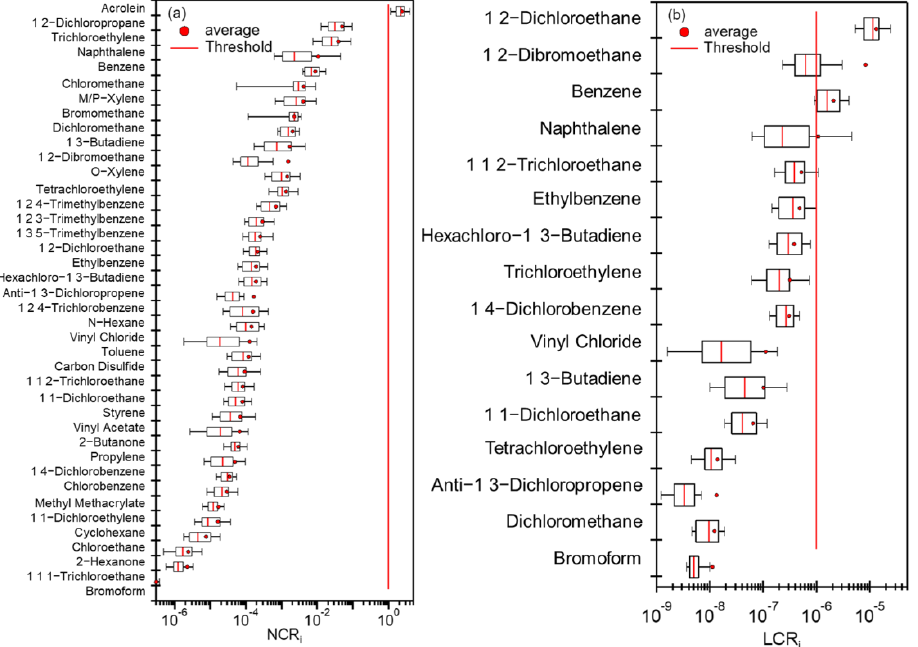
Figure 9. Calculated values of ( a ) noncarcinogenic risk (NCR) and ( b ) lifetime carcinogenic risk (LCR) for different VOCs (symbols of the boxes are the same as those described in Figure 3).